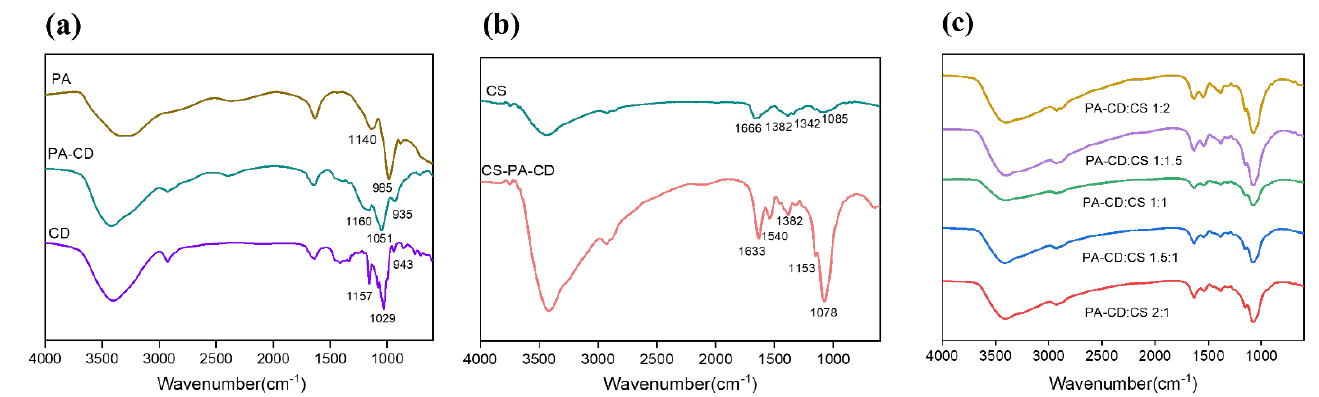
Figure 1. FTIR spectrum of ( a ) β -CD, PA, PA-CD, ( b ) CS and CS-PA-CD with ( c ) different ratios of PA-CD to CS.